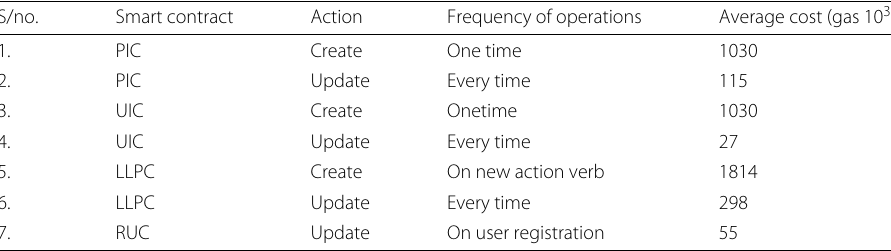
Table 7 Computational cost of smart contract operations